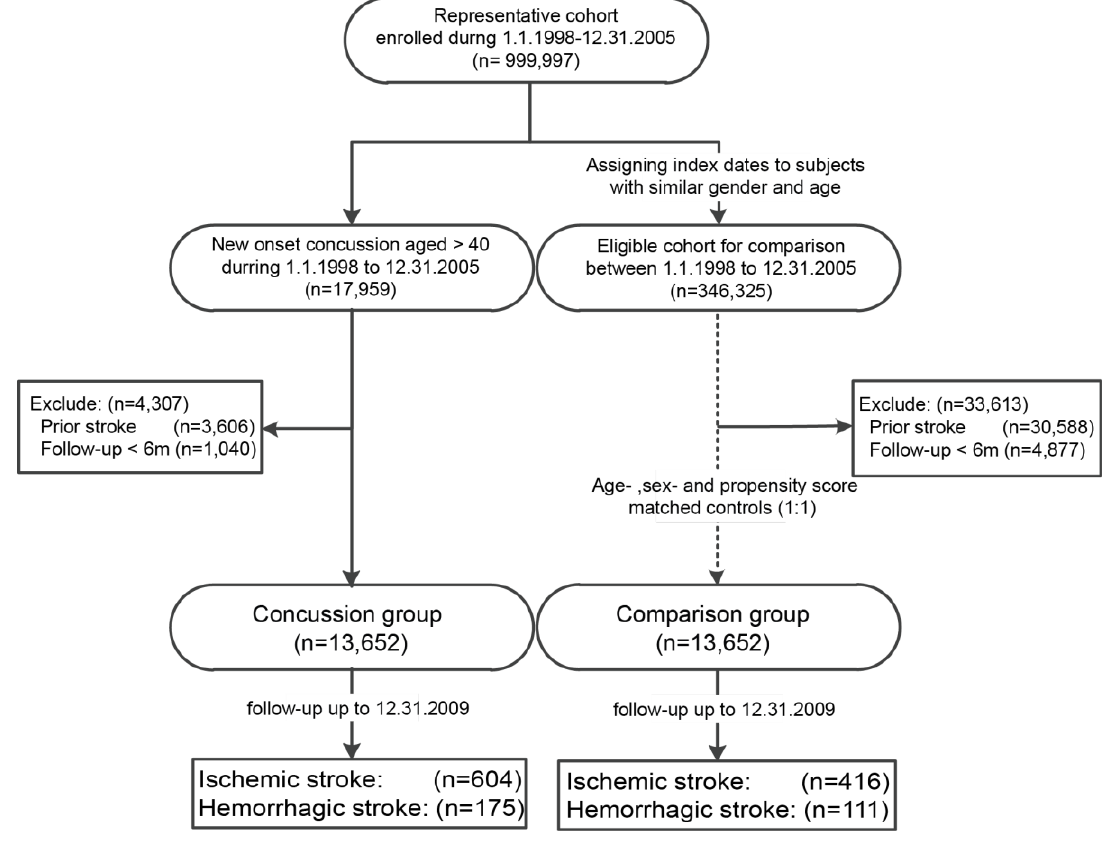
Figure 1. Flow of data processing.